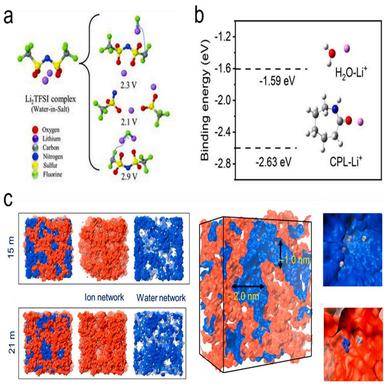
(a) Predicted reduction potentials from G4MP2 quantum chemistry calculations. (b) DFT calculations of binding energies of Li+–CPL and Li+–H2O. (c) MD-simulated structures of water H-bonding and ion networks. Snapshot structures of 15 M and 21 M LiTFSI electrolyte solutions are shown. A slab of an MD simulation box of a 21 M LiTFSI electrolyte is shown in middle, where blue and red regions correspond to water and ion aggregate, respectively. Reproduced with permissio